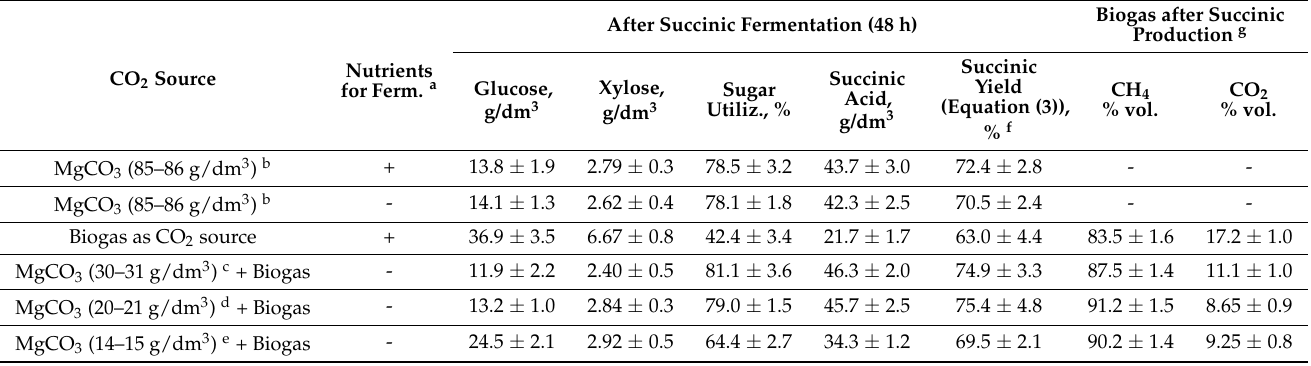
Table 3. Succinic acid production from hydrolysates after application of the most effective enzyme dosage (initial sugar concentration: 76.8 ± 3.5, average values n =3, ± represent standard deviations). After Succinic Fermentation (48 h) Biogas after Succinic Production g Succinic Nutrients Succinic Yield Xylose, Glucose, Sugar CH 4 for Ferm. a Acid, (Equation (3)), Utiliz., % % g/dm 3 g/dm 3 g/dm 3 % f